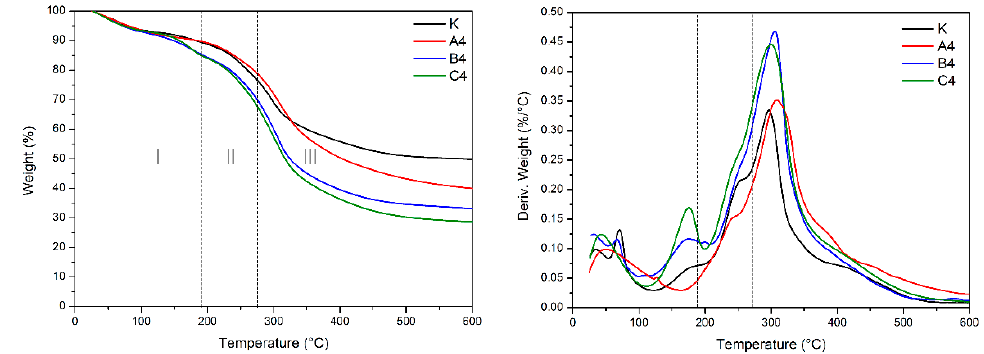
Figure 6. TG and di ff erential TG curves of the di ff erent soy meal samples on the 15th day: K (SM Figure 6. TG and differential TG curves of the different soy meal samples on the 15th day: K (SM adhesive), A4 (SM / 5% preservative A), B4 (SM / 5% preservative B), and C4 (SM / 5% preservative adhesive), A4 (SM/5% preservative A), B4 (SM/5% preservative B), and C4 (SM/5% preservative C).